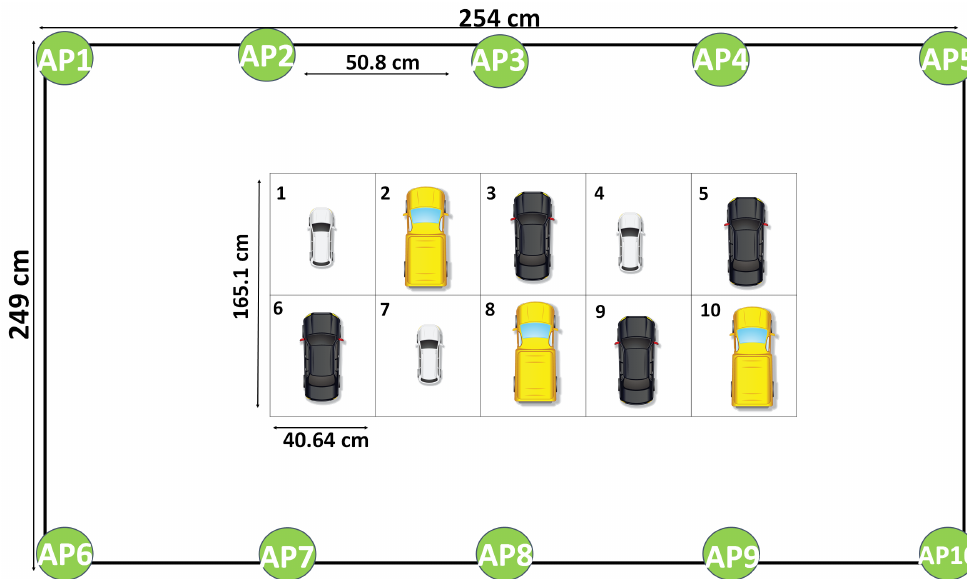
Figure 2. First testing site, which has no fixtures or any obstacles present and has 10 available parking slots.